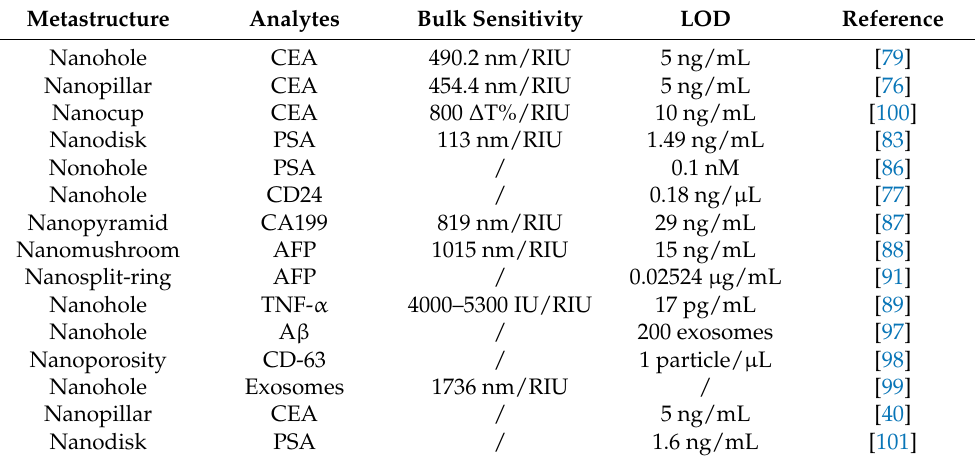
Table 1. Performances of tumor markers based on